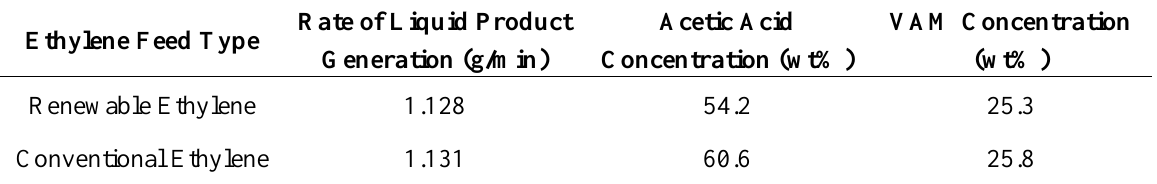
Table 3. A comparison of VAM concentrations in the VAM reactor liquid effluent with renewable acetic acid and either renewable or conventional ethylene Ethylene Feed